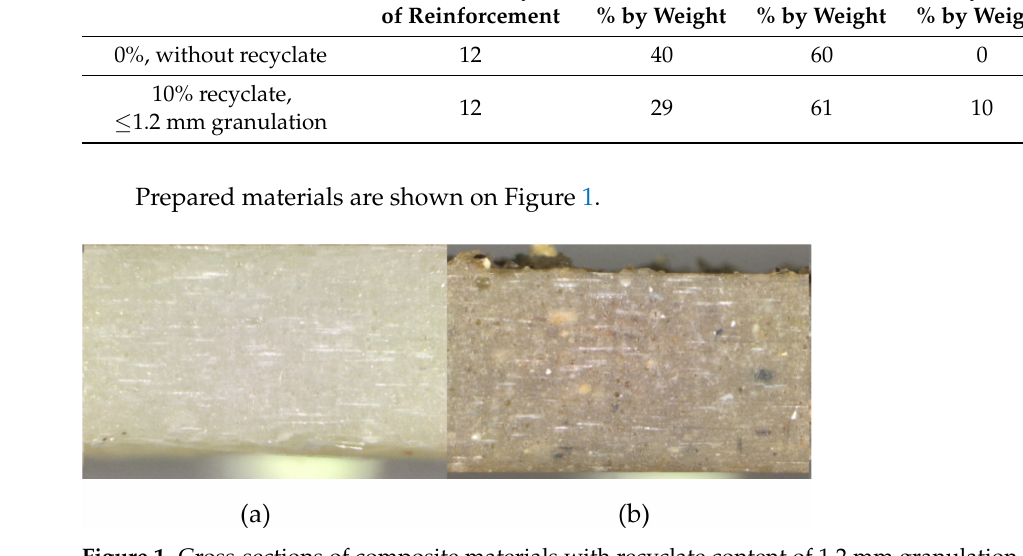
Table 1. The contents of% by weight of the reinforcement, matrix and recyclate in prepared materials. Number of Layers